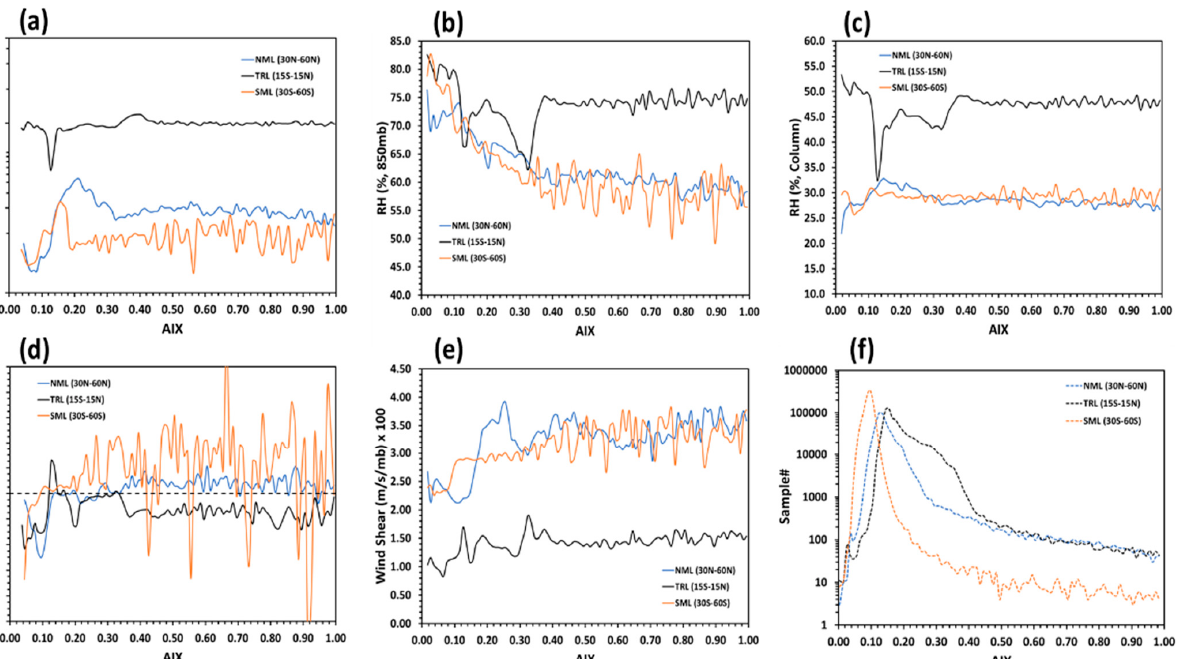
Figure 5. Statistic relationships of AIX with ( a ) CCF, ( b ) IWP, ( c ) CPER, ( d ) CTH, ( e ) CTT, and ( f ) COD for their long-term averaged values in the three latitudinal regions (NML, TRL, and SML).